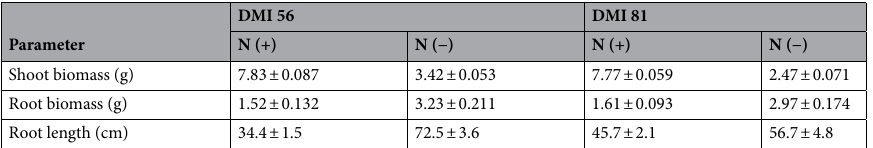
Table 1. Performance (biomass) of seedlings of tolerant (DMI 56) and susceptible genotype (DMI 81) grown under nitrogen sufficient [N (+)] and deficient [N (−)] nutrient solutions for 21 days.